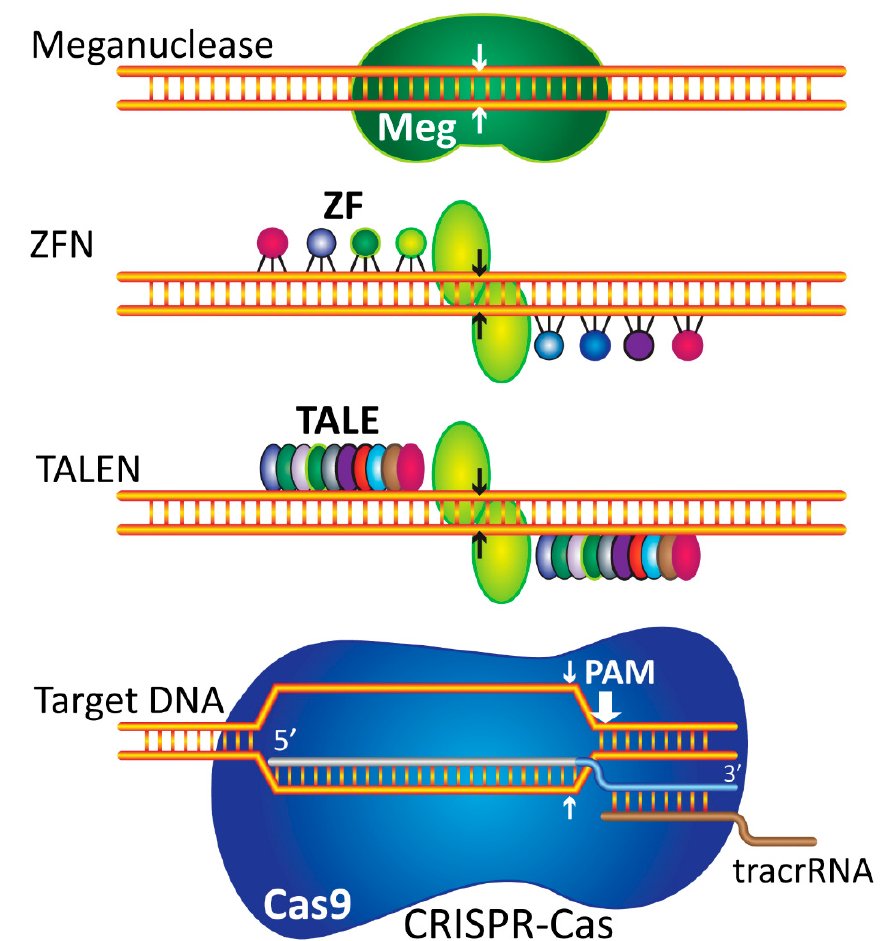
Figure 3. Gene editing tools. This figure reveals the mechanisms of targeted nucleases. From top to bottom: Meganucleases or homing endonucleases are nuclease enzymes that do not have separate DNA binding and cleavage domains, and recognize a 20–40 bp DNA sequence. Meganucleases may be utilized in all genome types to repair damaged genes in gene therapy by interrupting their DNA substrates as dimers.